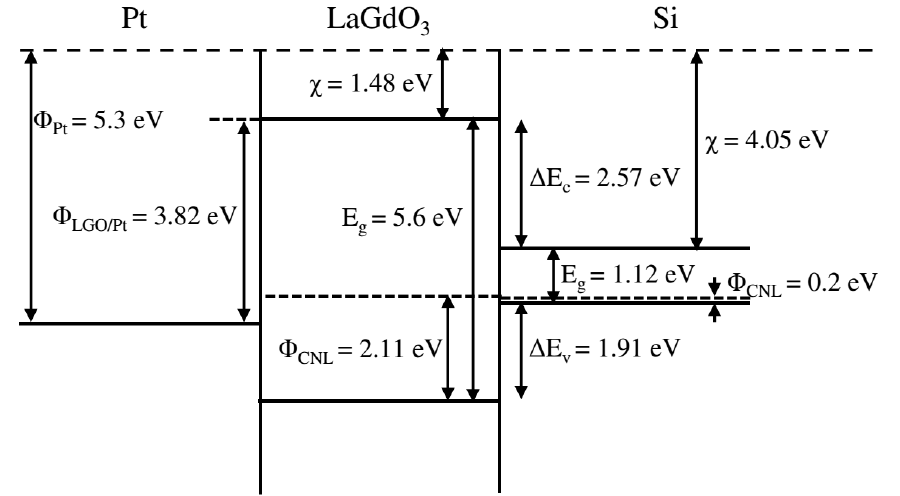
Figure 13. The energy band match-up diagram for the Pt/LaGdO flat-band